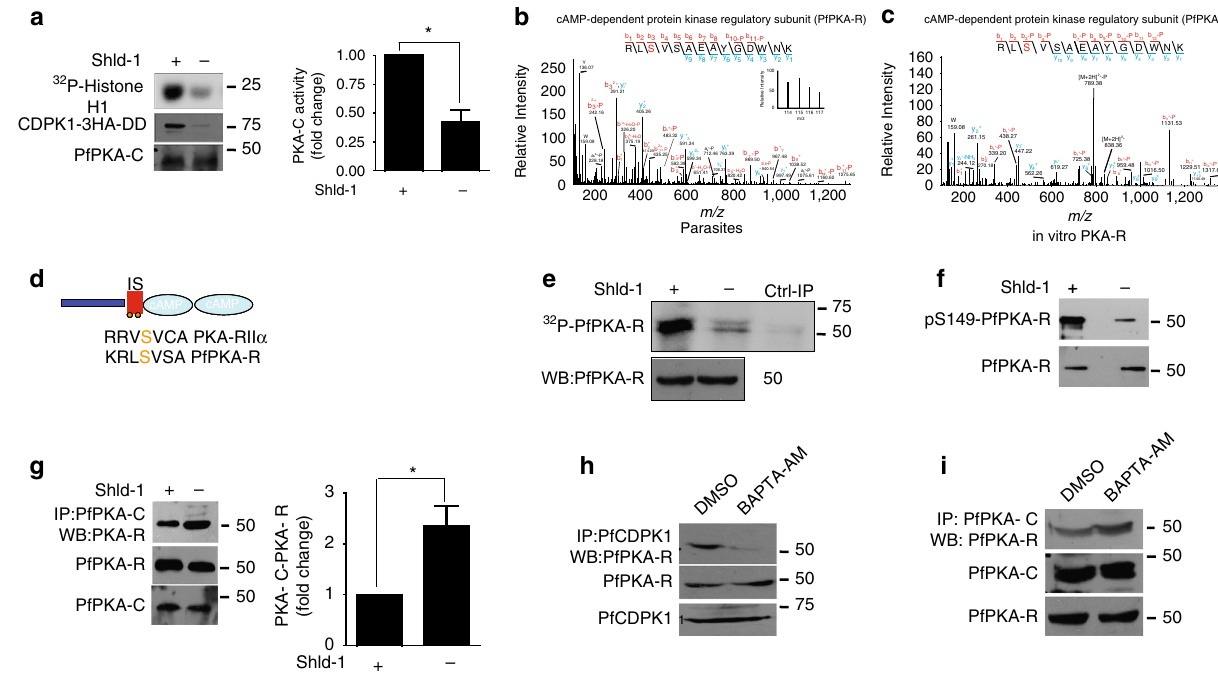
Fig. 3 PfCDPK1 regulates PfPKA-C by targeting PfPKA-R. a PfPKA-C was immunoprecipitated after Shld-1 removal from PfCDPK1-3HA-DD parasites. PfPKA-C-IP was used to assay kinase activity using Histone H1 as substrate and its phosphorylation was detected by phosphorimaging and quanti fi ed